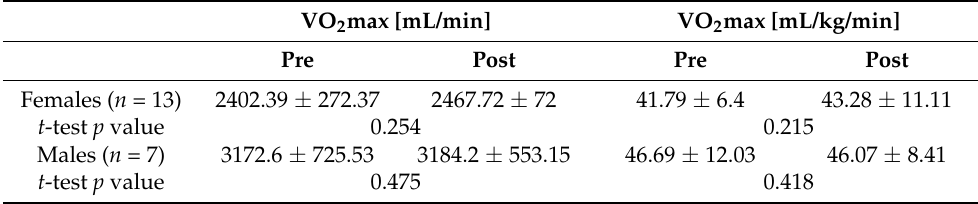
Table 2. Maximal oxygen consumption in examined students in 14-week period of COVID-19 pandemic. Data are presented as mean value ± standard